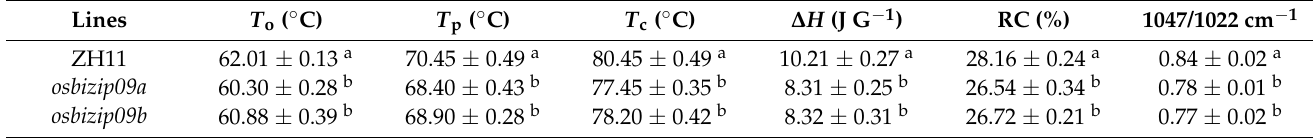
Table 2. Thermal and crystallinity parameters of rice starches from different rice lines 1